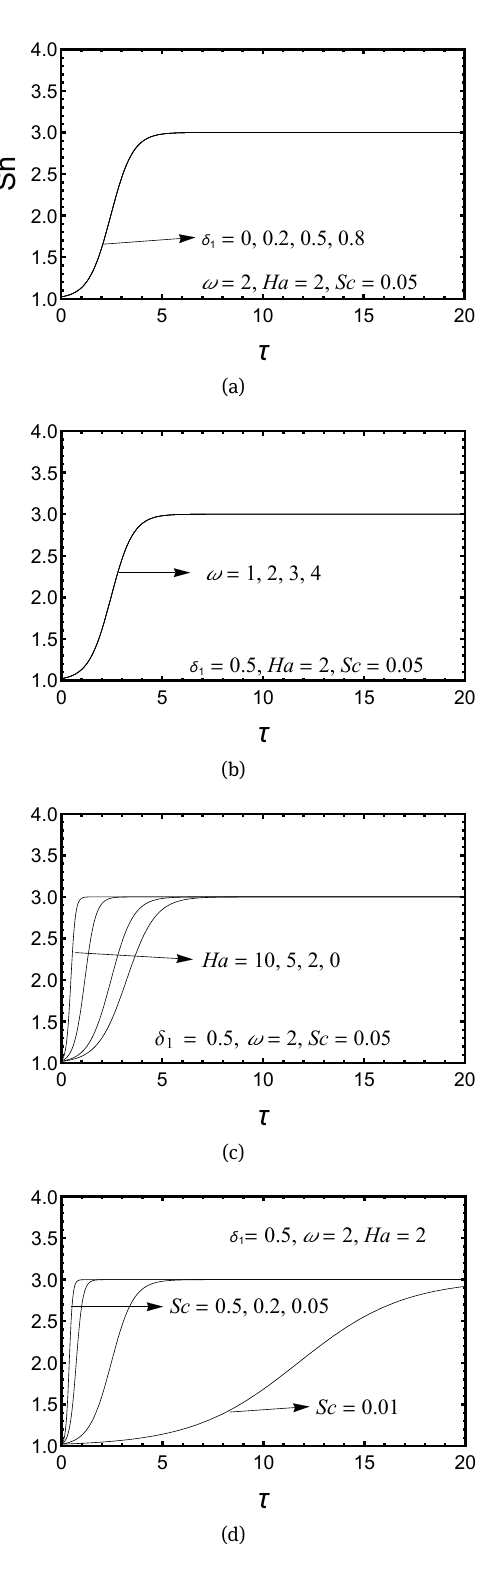
Fig. 1: Variation of Sherwood number Sh with time τ for in phase concentration modulation for different value of (a) δ 1 , (b) ω , (c) Ha , (d) Sc